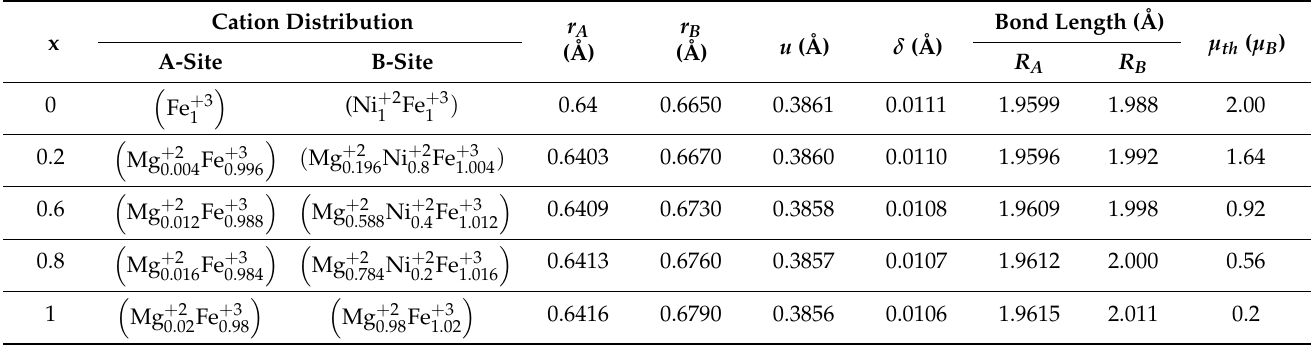
Table 1. X-ray cation distribution, ionic radius of the (A) position ( r A ), ionic radius of the (B) position ( r B ), oxygen positional parameter ( u ), inversion parameter ( δ ), and bond length of A-site ( R A )